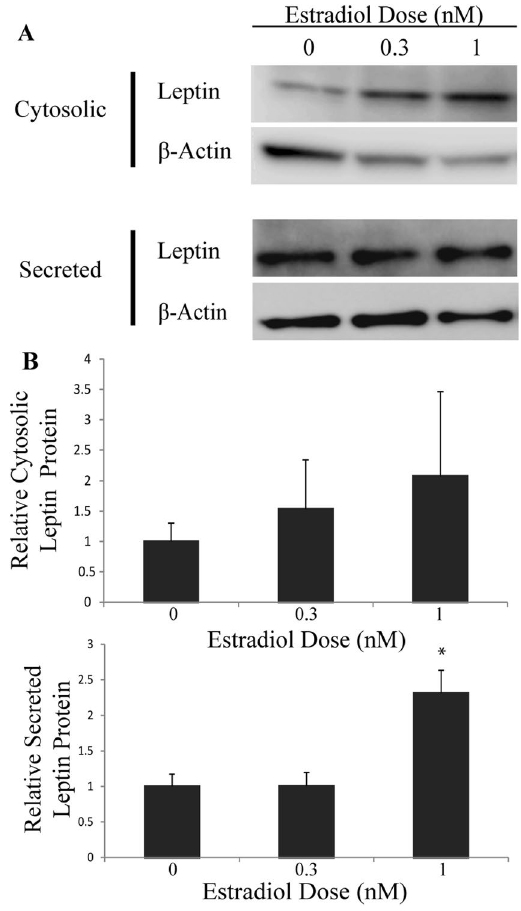
Figure 7. Secreted leptin significantly increased in cells treated with 1 nM estradiol. Cells were treated for 24 hours with estradiol after a 6 hour serum deprivation. ( A ) Cytosolic proteins were quantified in a cell extract and supernatants were collected for analysis with Western blots with a leptin-specific antibody. ( B ) Protein levels were normalized to actin and are reported relative to the untreated control with n ≥ 5 biological replicates; * Denotes p-value ≤ 0.05 when compared to control with 2-sample, independent Student’s t-tests. The blots in this image are cropped and full length images are shown in Supplemental Fig.